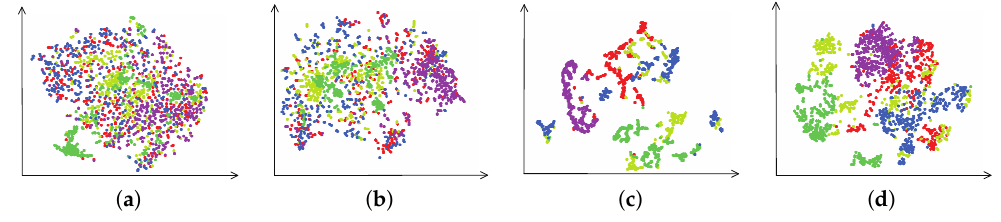
Figure 8. Visualizations of feature in 2D space by using t-SNE. Each sample is visualized as a point and samples with the same color belong to the same class. ( a ) raw polarimetric feature; ( b ) sparse and low-rank subspace feature; ( c ) deep spatial feature; ( d ) integrated hierarchical subspace